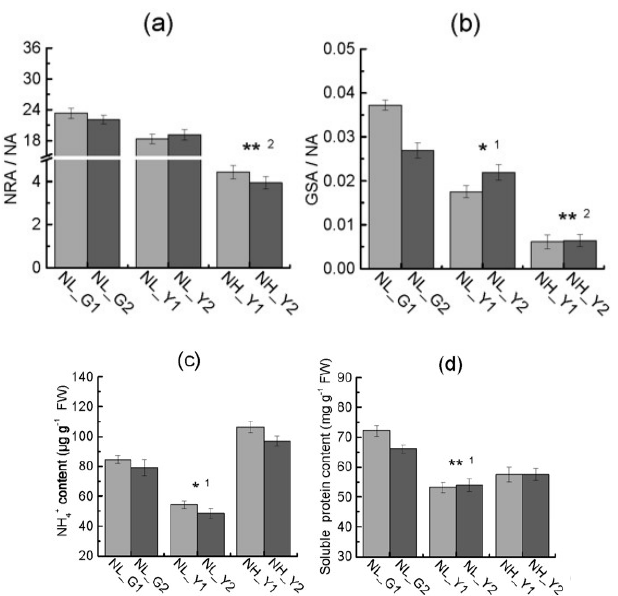
Figure 6. Differences in NRA/NA ( a ), GSA/NA ( b ), NH 4+ content ( c ) and soluble protein content ( d ) between the two types at the same nitrogen level and same leaf biomass accumulation condition. NA: Nitrogen application level; NRA/NA: Ratio of nitrate reductase activity to nitrogen application level; GSA/NA: Ratio of glutamine synthetase activity to nitrogen application level. NL_G1: low nitrogen level, HD; NL_G2: low nitrogen level, Z100; NL_Y1: low nitrogen level, TN90; NL_Y2: low nitrogen level, TN86; NH_Y1: high nitrogen level, TN90; NH_Y2: high nitrogen level, TN86. Error bars indicate standard error of the means ( n = 3). Symbols ** 1 and * 1 indicate that the significant differences between flue-cured tobacco and burley tobacco at the same nitrogen application are at 0.01 and 0.05, respectively. Symbols ** 2 indicate that the significant differences between flue-cured tobacco and burley tobacco at the same leaf biomass accumulation condition are at 0.01, respectively.